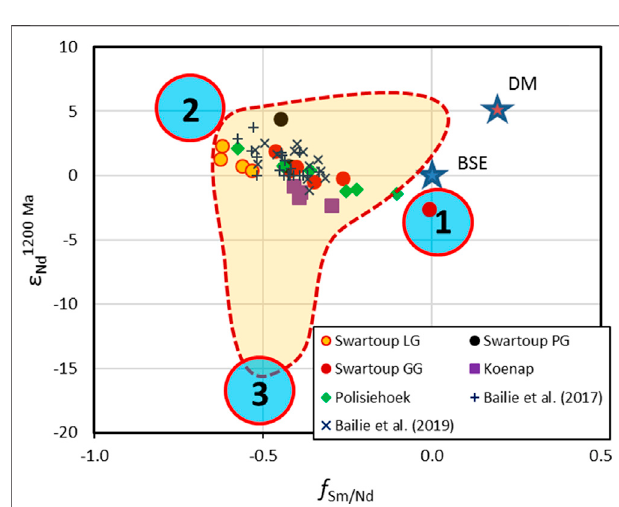
FIGURE 10 | Chondrite-normalized Sm/Nd ratio (f Sm/Nd ) plotted against ε Nd1200 . Pale orange fi eld with dashed border: Namaquan crust based on Yuhara et al. (2002), Eglington (2006) and Pettersson et al. (2009). DM, depleted mantle; BSE, bulk silicate Earth, as represented here by the Chondritic Uniform Reservoir (CHUR) composition to which the plot is normalized. The three blue circles indicate the minimum number and suggested compositional characteristics of end-members required to explain the distribution of data for the Swartoup Hills granitoids. See text for